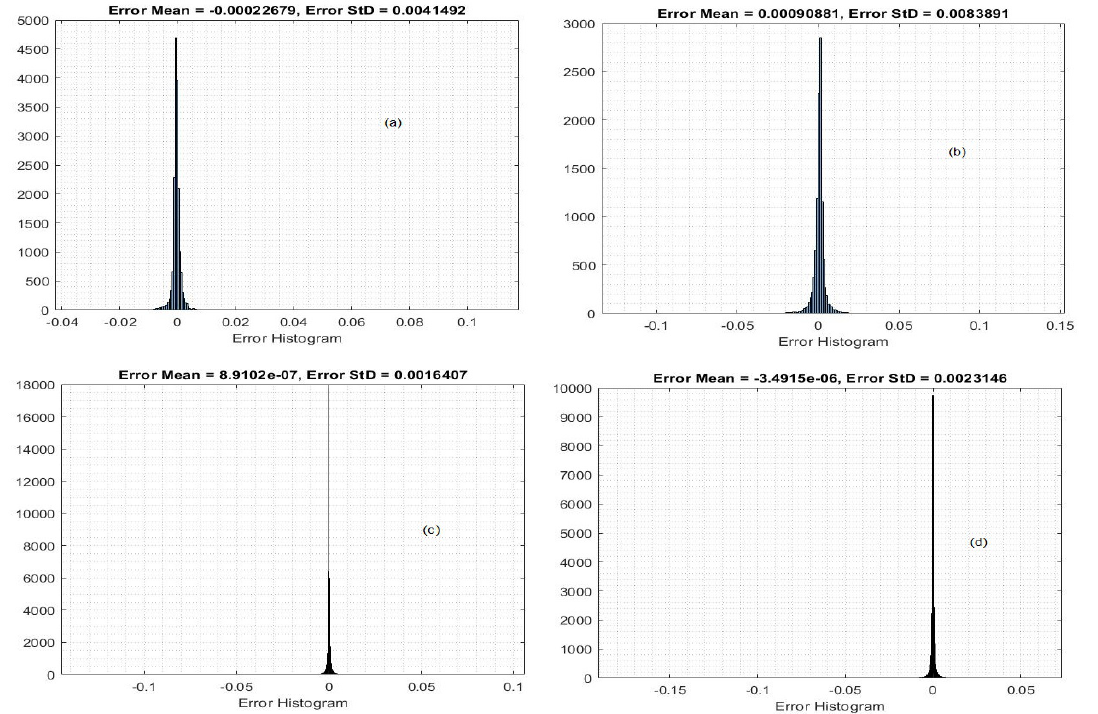
Figure 8. Histogram error of LSTM in the training phase, ( a ) communication ( b ) energy, ( c ) financial and ( d ) industrial sectors.